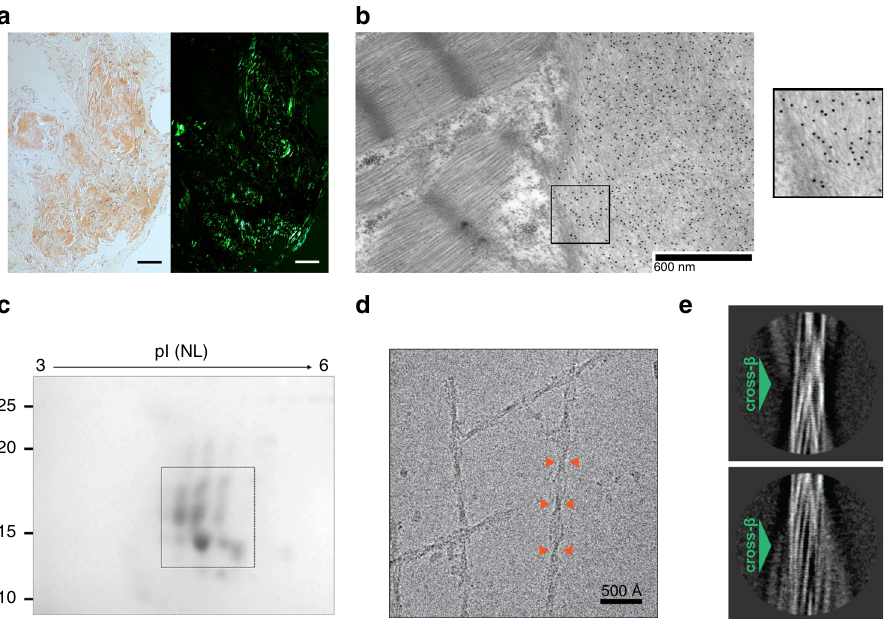
Fig. 1 Morphological and molecular characterization of AL55 fi bril deposits. a Myocardial tissue from patient AL55, stained with Congo red. Red-orange stain and apple-green birefringence indicate amyloid deposits under visible (left) and under polarized light (right), respectively (magni fi cation ×100; scale bar 100 μ m). b Immuno-electron microscopy imaging of heart tissue from patient AL55 (magni fi cation ×6000). Extracellular amyloid fi brils are visible on the right side: the gold-conjugated secondary antibody appears as black dots. The cardiomyocyte sarcomeres are visible in the upper left corner. Scale bar: 600 nm. The squared portion is zoomed in the inset on the right. c 2D-PAGE analysis of puri fi ed AL55 LC fi brils (inset from Supplementary Information Fig. 1b, left panel), showing the spots identi fi ed by MS as AL55 LC fragments (framed). These encompass the full V l and variable portions of C l (MS sequence coverage ranges from aa 1 – 129 to aa 1 – 150). Low and high MW fragments comprise residues from the N-terminus to residue 129, and to 150, respectively. d Representative cryo-EM micrograph of AL55 LC fi brils; orange arrows highlight fi bril cross-overs. e Reference-free 2D class averages of AL55 fi bril showing distinct cross- β staggering (green